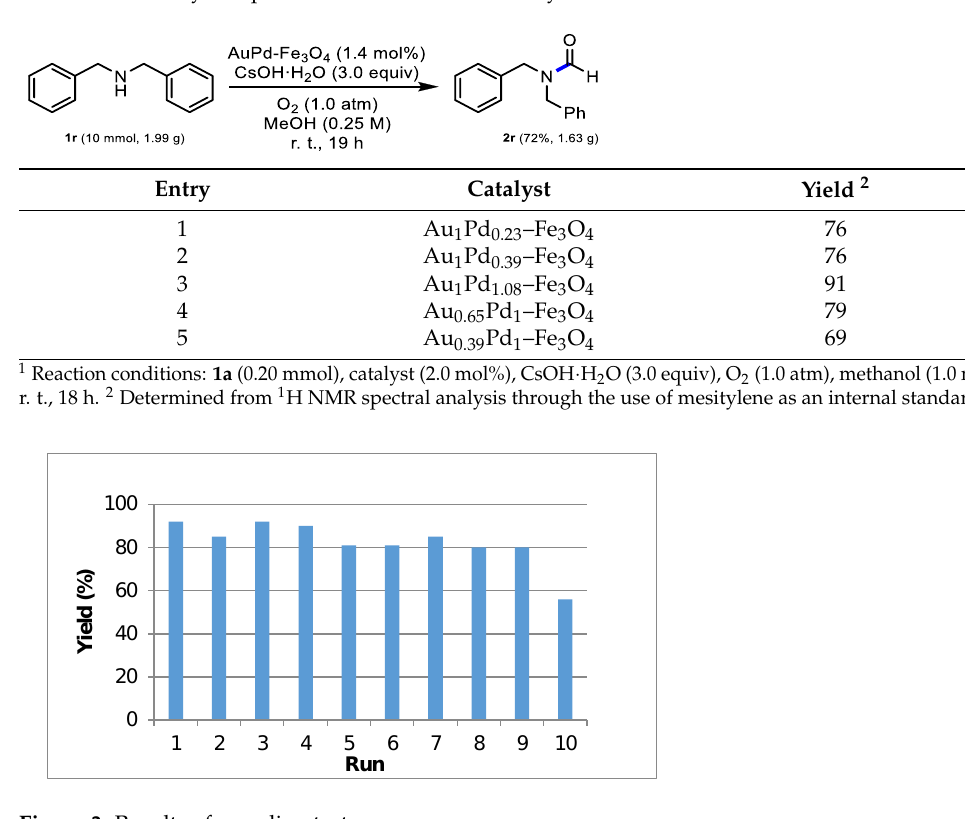
Figure 3. Results of recycling test.